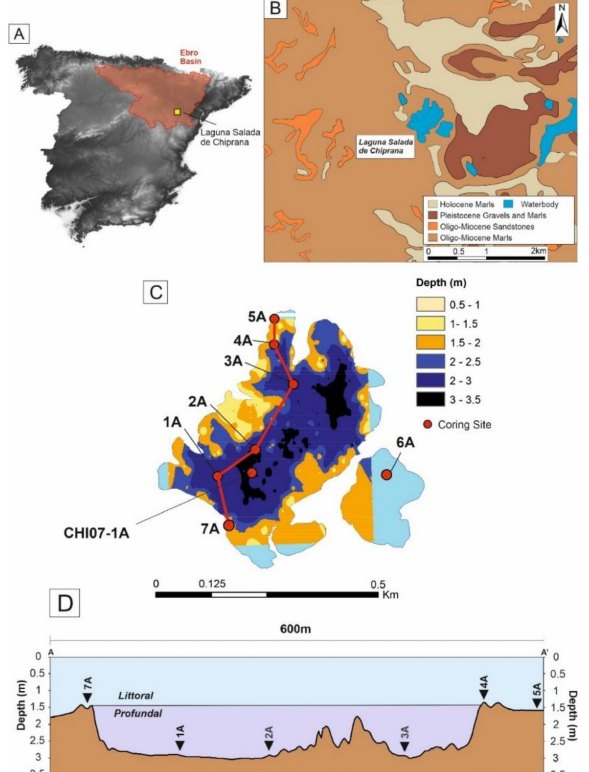
Figure 1. Maps illustrating the location of Laguna Salada de Chiprana in Northeast Spain. ( A ) Digital elevation model of the Iberian Peninsula generated using ArcMap 10.14.1 with the location of the Ebro Basin highlighted in red. The location of Laguna Salada de Chiprana is marked by a yellow square. ( B ) Regional geology of the area of Laguna Salada de Chiprana. ( C ) Bathymetric map of Laguna Salada de Chiprana with sediment cores collected from the lake during March 2019 highlighted. ( D ) Bathymetrical cross-section, oriented NE-SW, of the main basin of Laguna Salada de Chiprana with all cores (with the exception of 6A, located in the side lagoon) marked on the section. Geological data sourced from [31], DEMs from CNIG (Centro Nacional de Informacion Geografica), bathymetrical data provided by the Instituto Pirenaico de Ecologica. Figure partially modified from